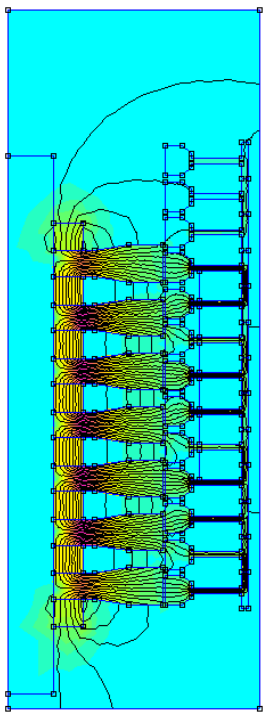
Figure 6. Field distribution within the TPMLiG